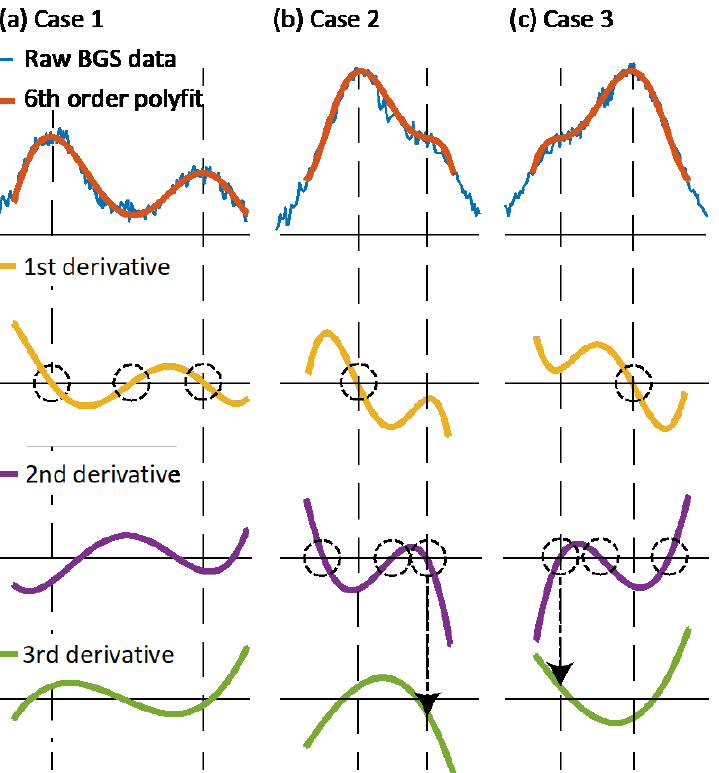
Figure 4. Proposed method for finding a first guess of the Brillouin resonance peaks based on a high-order polynomial curve fitting and its three first order derivatives. There cases are shown: a case with large spectral separation (Case 1), and two cases with overlapping peaks (Cases 2 and 3).